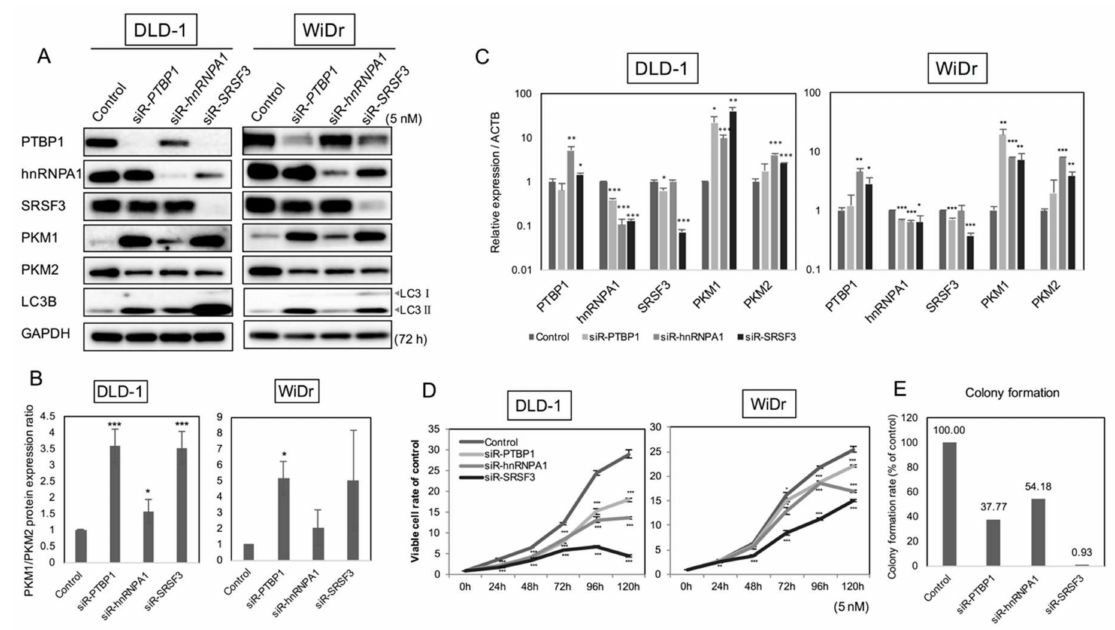
Figure 2. Effects on PKM gene and protein expression by silencing of PTBP1 , hnRNPA1 , or SRSF3 in colorectal cancer cell lines DLD-1 and WiDr. ( A ) Western blot of PTBP1, hnRNPA1, SRSF3, PKM proteins, and LC3B prepared at 72 h after transfection of DLD-1 and WiDr cells with short-interfering RNA (siRNA) for PTBP1 , hnRNPA1 , and SRSF3 (5 nM). PTBP1, hnRNPA1, SRSF3, and GAPDH were detected in the same membrane; ( B ) PKM1/PKM2 ratio calculated by densitometric values of PKM1 and PKM2 in (A). Control is indicated as 1.0; ( C ) mRNA expression levels in DLD-1 and WiDr cells at 72 h after transfection with each siRNA (5 nM); ( D ) Time-dependent cell growth of DLD-1 and WiDr cells transfected with each siRNA (5 nM), as determined by performing trypan blue staining; ( E ) Results of colony formation assay for DLD-1 cells transfected with each siRNA (5 nM). * p < 0.05, ** p < 0.01, *** p < 0.001 (Student’s t